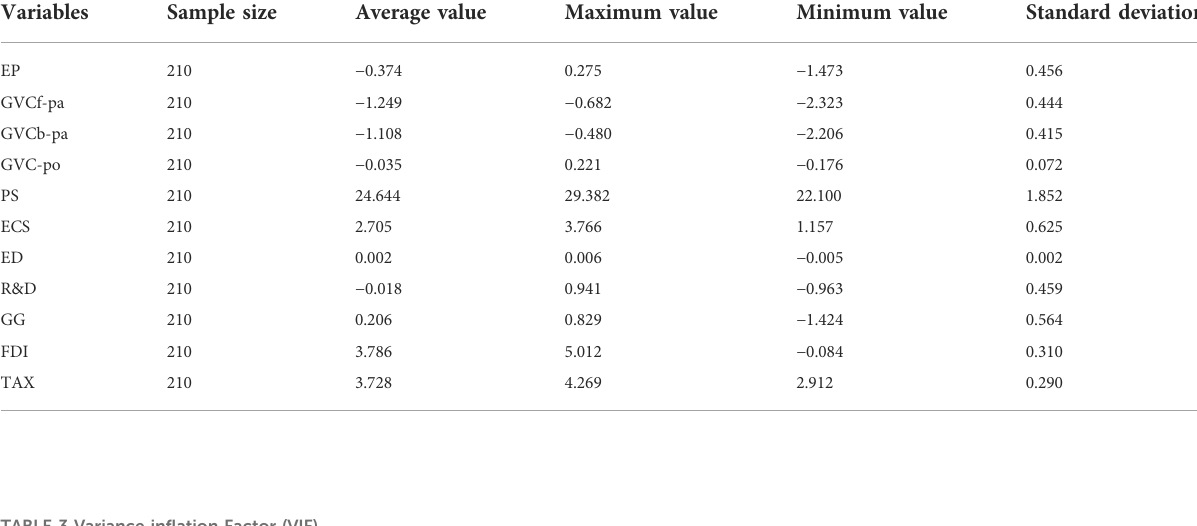
TABLE 3 Variance in fl ation Factor